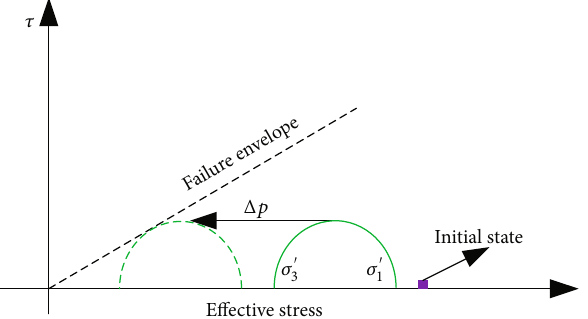
Figure 2: Schematic diagram of mechanical stability of caprock